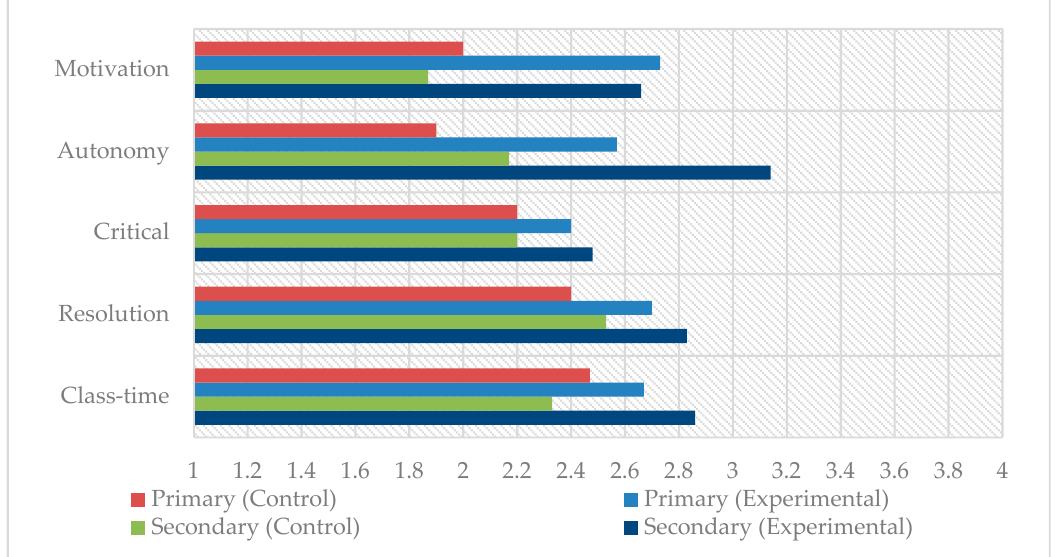
Figure 1. Intergroup comparison in attitudinal dimension.